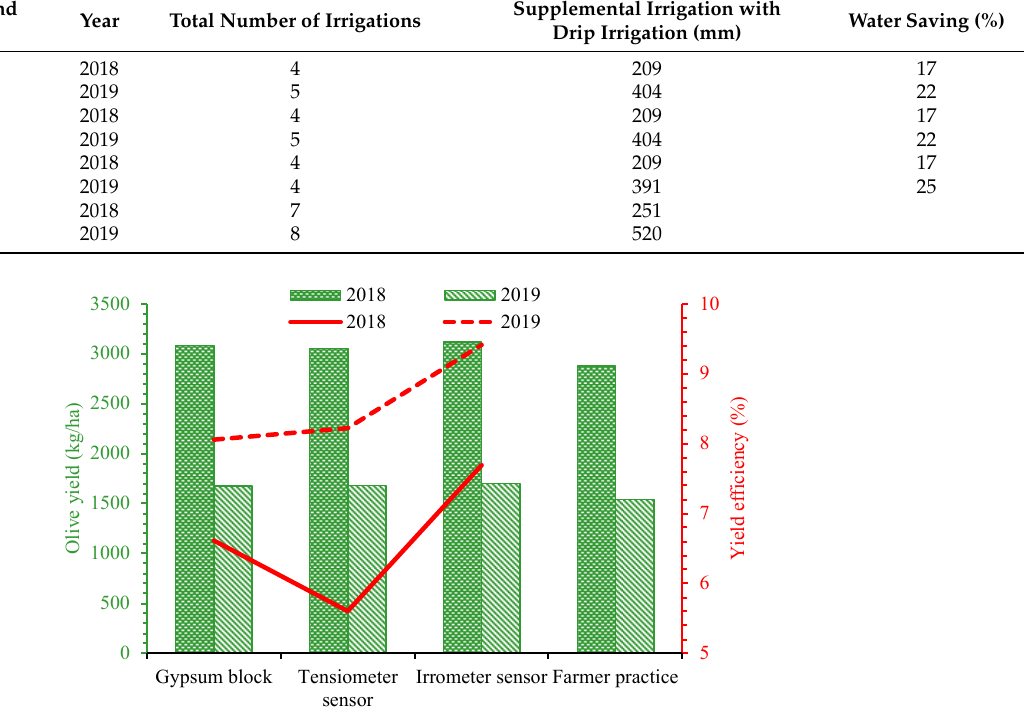
Figure 11. Comparison of olive yield and yield efficiency using different soil moisture sensors as compared to conventional farmer practice.